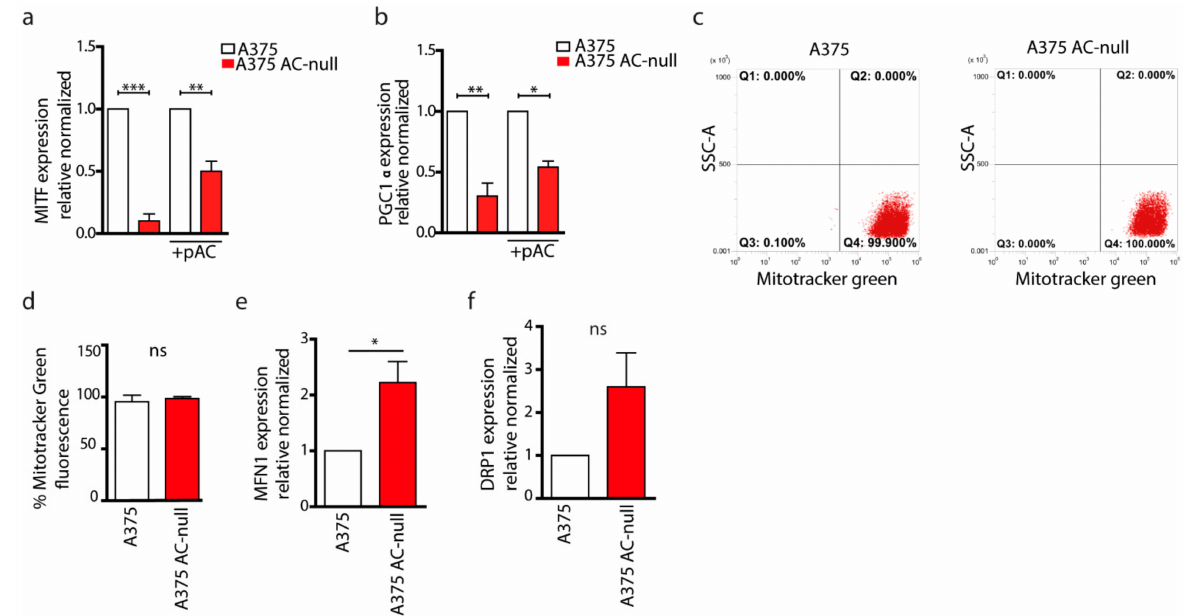
Figure 4. AC ablation results in altered MITF/PGC1 α signaling. ( a ) Cells were transfected or not with pAC. Real-time PCR of MITF on A375 and A375 AC-null cells were performed. Results are expressed as mean ± SD, with each experiment performed three biological and technical triplicates (** p < 0.01, *** p < 0.001, One Way ANOVA and Bonferroni post hoc test). ( b ) Real-time PCR of PGC1 α on A375 and A375 AC-null cells, transfected or not with pAC. Results are expressed as mean ± SD, with each experiment performed three biological and technical triplicates (** p < 0.01, *** p < 0.001, One Way ANOVA and Bonferroni post hoc test). ( c ) Mitochondria in A375 and A375 AC-null cells were labelled with MitoTracker Green for 30 (cid:48) at 37 ◦ C. Cells were then washed and analysed by flow cytometry. ( d ) Statistical analysis of MitoTracker Green fluorescence intensity on A375 AC-null cells compared to A375 WT cells. Data are expressed as mean ± SD and experiments were performed in three biological and technical replicates (Student’s t -test). ( e , f ) Real-time PCR of MFN-1 and DRP-1 on A375 and A375 AC-null. Results are expressed as mean ± SD, with each experiment performed three biological and technical triplicates (* p < 0.05 Student’s t-